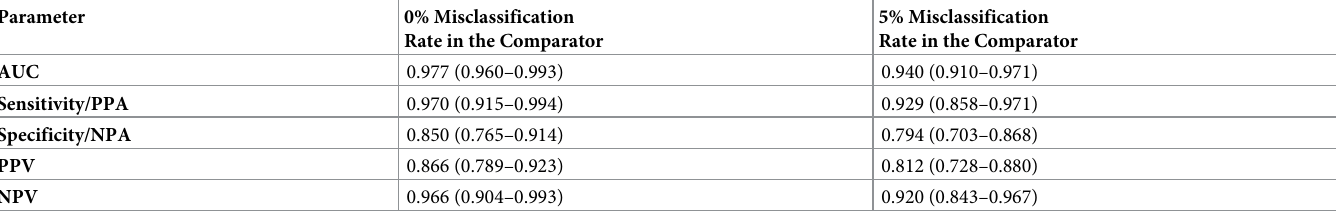
Table 1. Effect of uncertainty in the comparator on estimates of test performance.